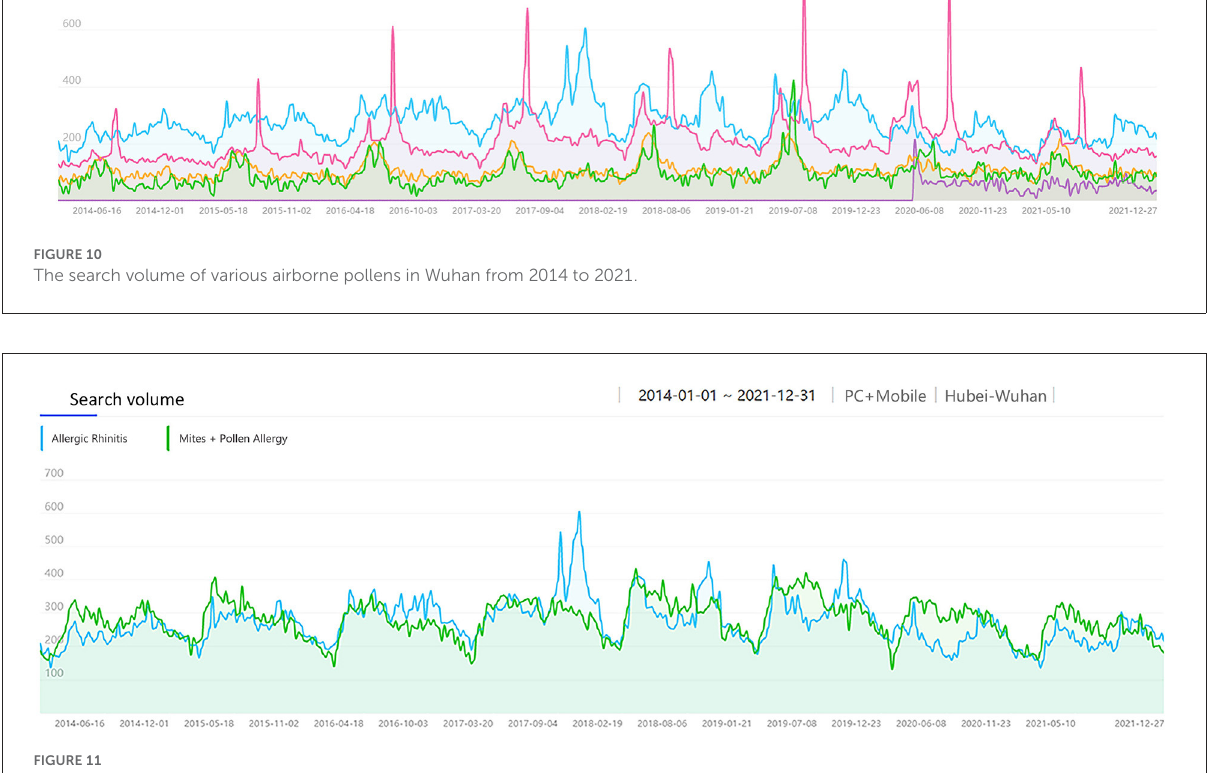
FIGURE11 The search volume of “AR” and “Mites + Pollen Allergy” in Wuhan from 2014 to 2021.